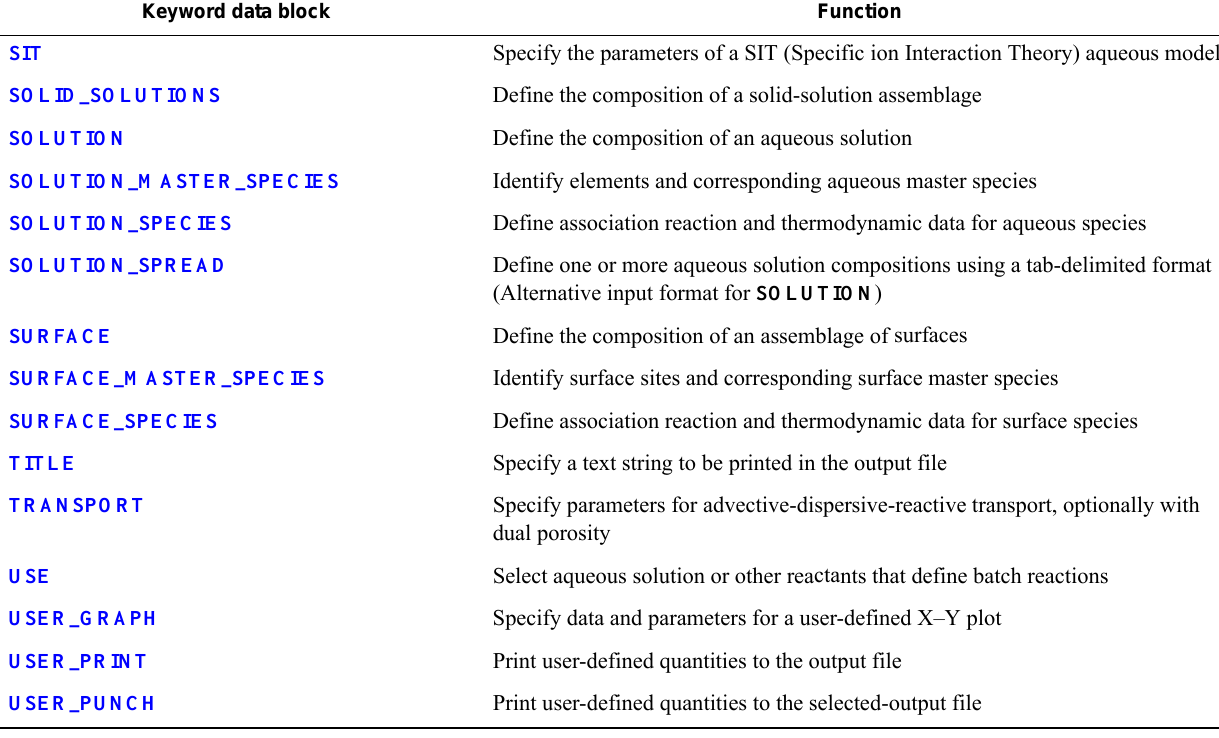
Table 1. List of keyword data